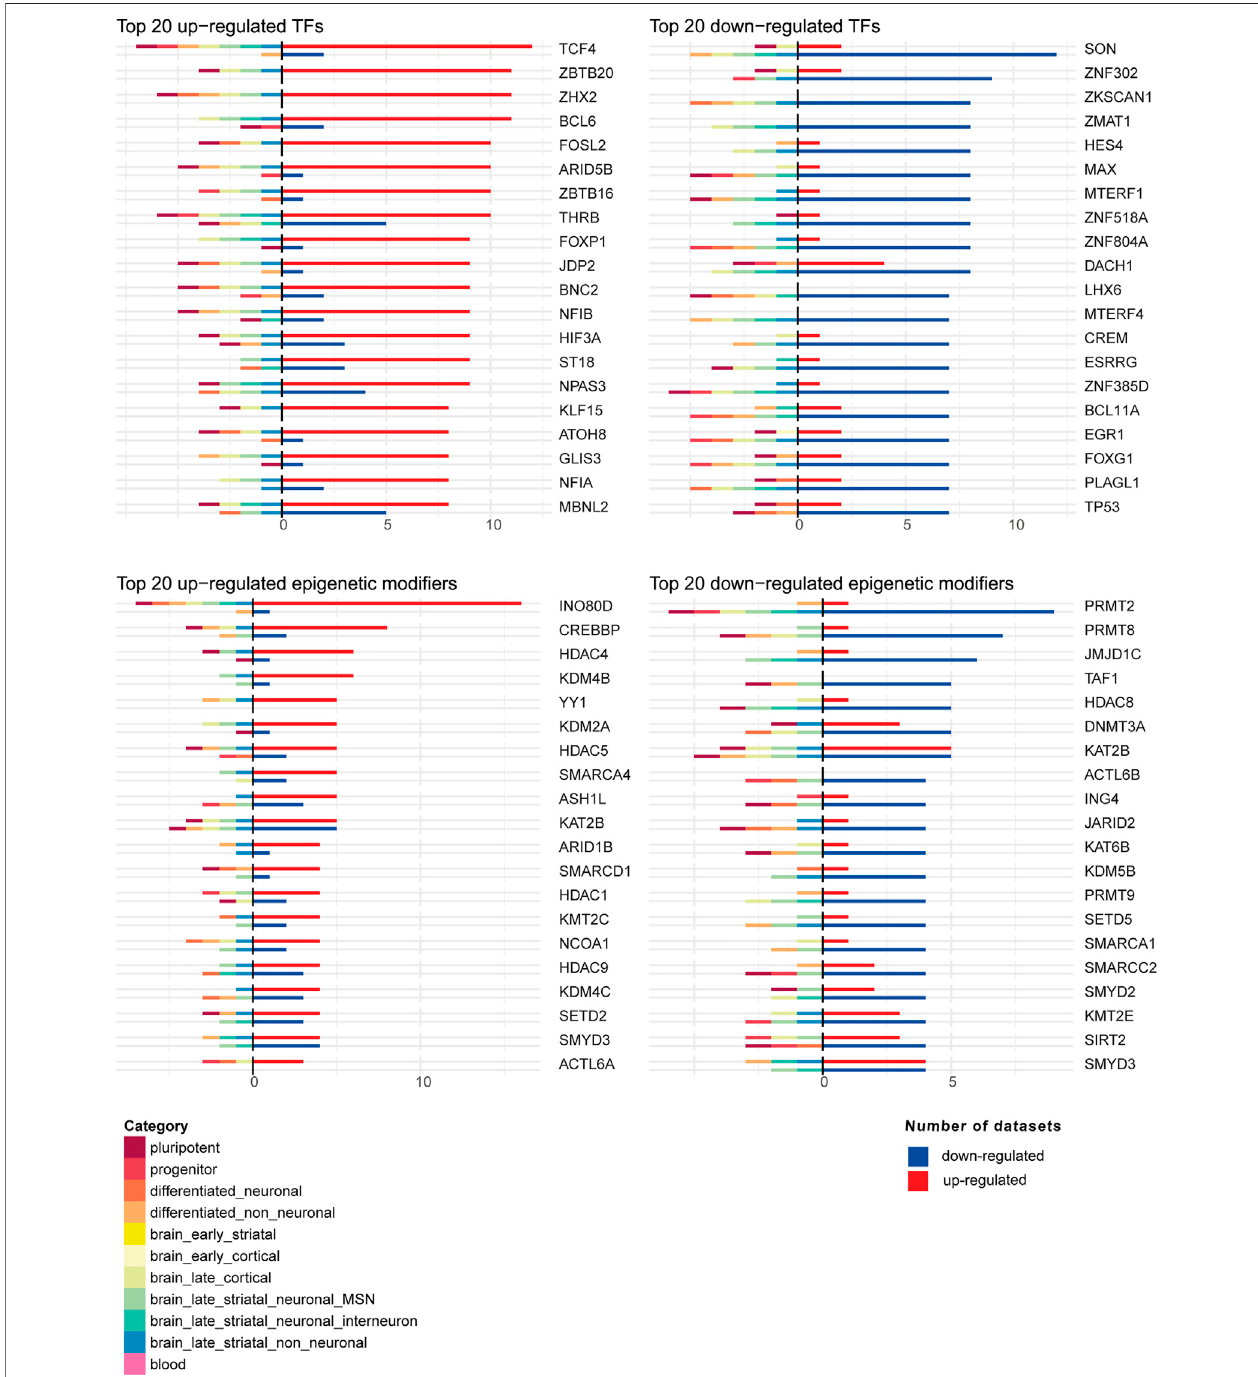
FIGURE6| Top20up-regulatedanddown-regulatedtranscriptionfactors(TFs)andepigeneticmodi fi ersinthe44humanDEGdatasets.ForeachTForepigenetic modi fi er, shown were the numbers of datasets where the TF or epigenetic modi fi er was up-regulated or down-regulated. On the positive axis, the number ofdatasets in which the TF or epigenetic modi fi er is up-regulated or down-regulated are shown. On the negative axis, the category membership of the datasets where the TF or epigenetic modi fi er is up-regulated or down-regulated is indicated.